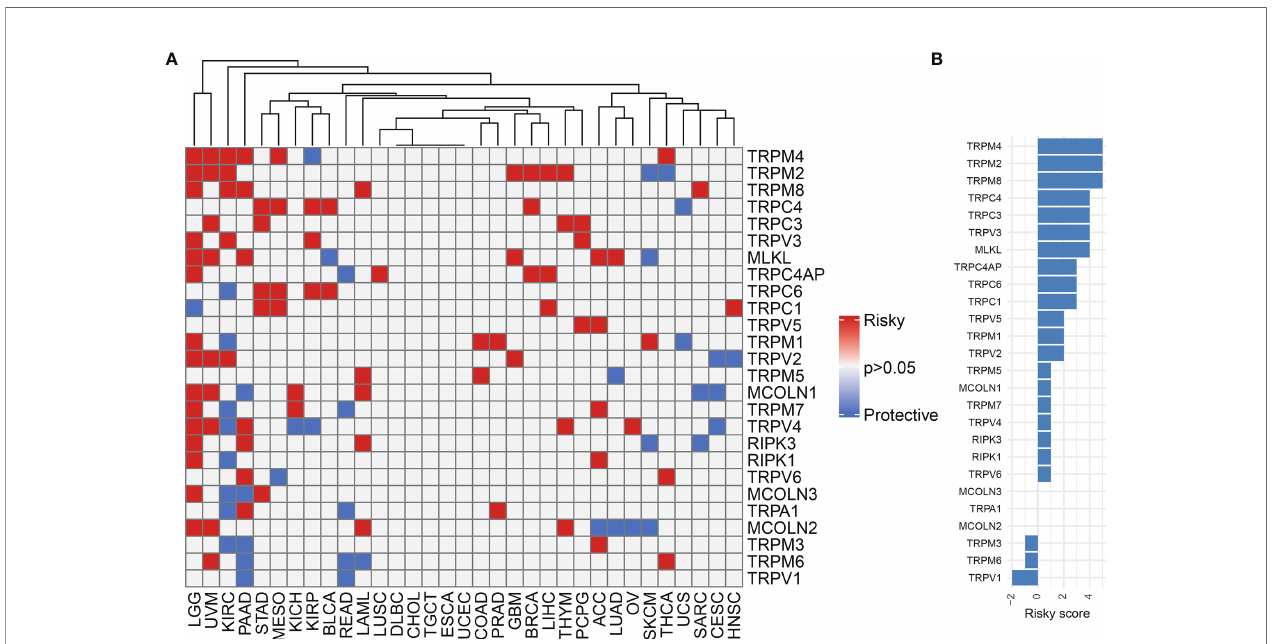
FIGURE 2 | The prognostic value of TRP family genes. (A) Heatmap of the uniCox results of TRP family genes in each tumour type. (B) The risk score of each TRP family gene in pan-cancer.